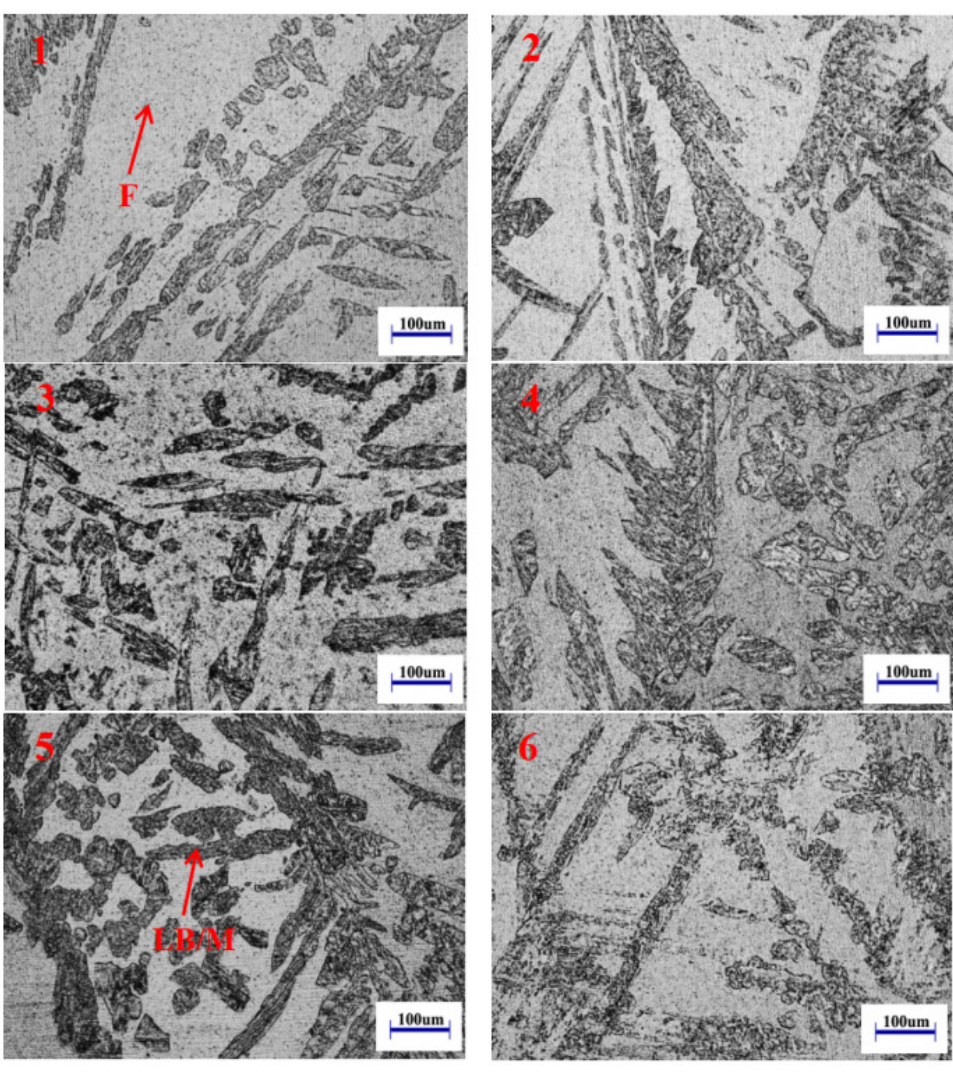
Figure 13. Microstructure of weld zone at different holding times: ( 1 ) 30 s, ( 2 ) 2 min, ( 3 ) 5 min, ( 4 ) 15 min, ( 5 ) 1 h, ( 6 ) Complete recrystallization .